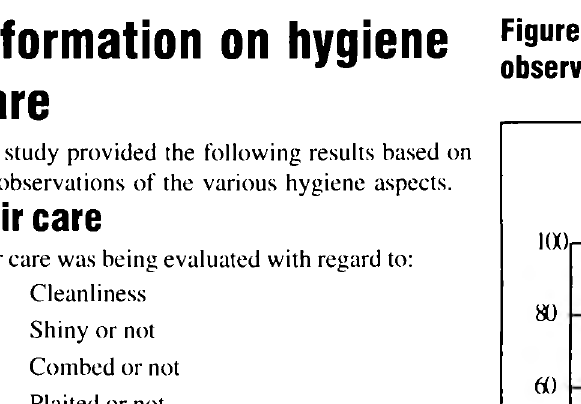
Figure 2: Outcome of eye care as percentage of total observations (N=30)